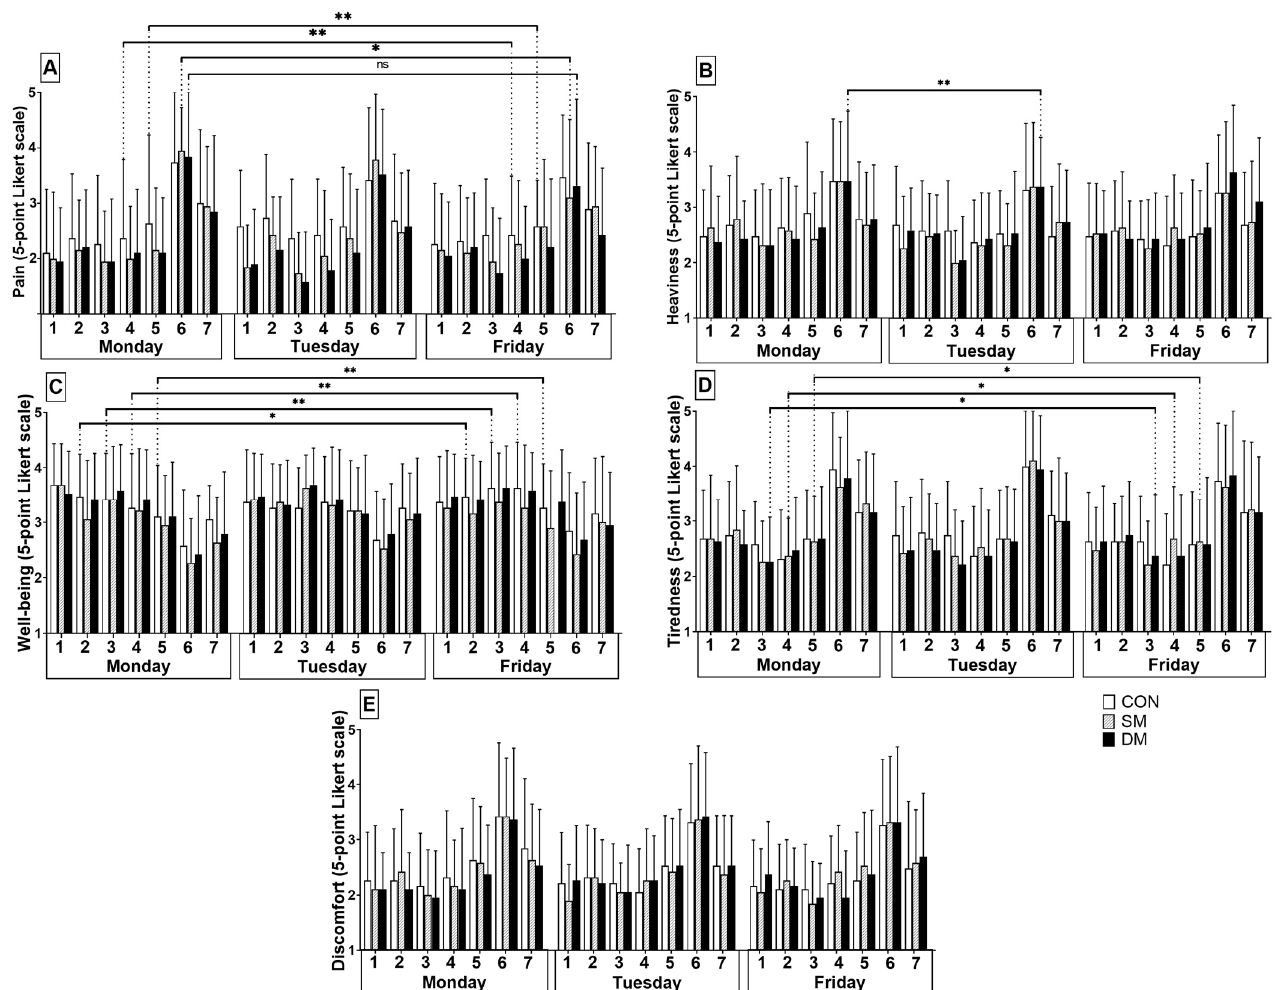
Figure 4. Behavior of perceptions of ( A ) pain, ( B ) heaviness, ( C ) well-being, ( D ) tiredness, and ( E ) discomfort during the training sessions of intervention days. (1 = before resistance training, 2 = after resistance training, 3 = after intervention, 4 = swim warm-up, 5 = after swim warm-up, 6 = main series, 7 = after swim training, * = p < 0.05, ** = p < 0.01, ns = non significant).